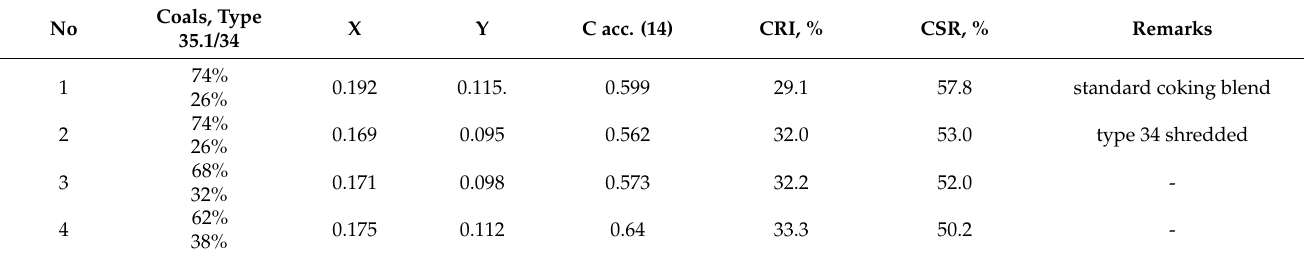
Table 6. Coordinates of coal blends and coke quality.